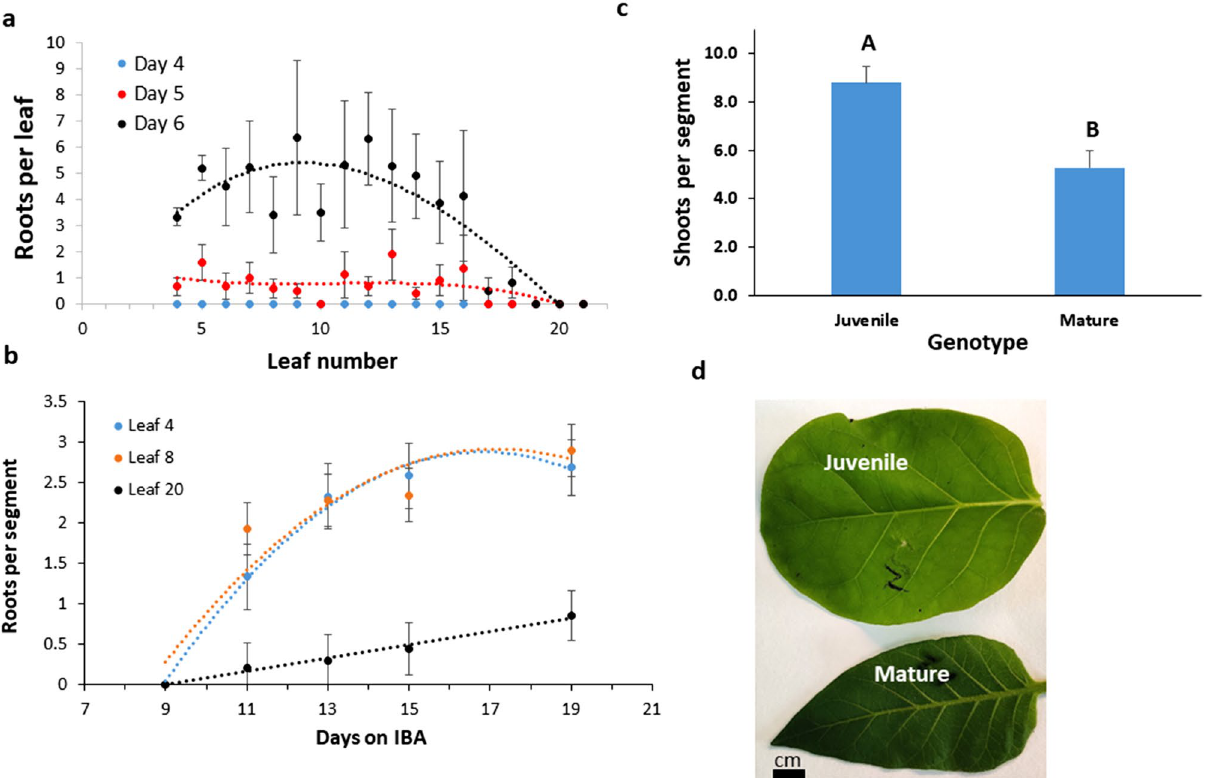
Figure 1. Effect of leaf age on regeneration. Tobacco leaves were detached at the plant’s petiole-stem junction and numbered starting from the first true leaf and were placed in agar supplemented with IBA. ( a ) The number of roots ± SE regenerated from leaf petioles were counted after 4, 5, and 6 days in IBA each day. The experiment was done in 2 replicates with 5–7 leaves each leaf number. Percent regeneration can be seen in figure S2. ( b ) The number of roots ± SE regenerated from leaf blades of juvenile (leaf 4 or 8) or mature (leaf 20) leaves. The experiment was done in 3 replicates and each 10–15 leaf segment. Percent regeneration can be seen in Fig. S3. ( c ) The number of shoots ± SE regenerated from leaf blades was counted after 30 days on the regeneration medium of mature (leaf 20) or juvenile (leaf 8) segments. The experiment was done in 3 replicates, and each had 20–25 leaf segments. Percent regeneration can be seen in Fig. S3. ( d ) Phenotype difference between mature and juvenile leaves. Statistical analysis was conducted among each color group using the JMP program using Tukey analysis. Different letters depict statistically significant differences between genotypes or treatments (p{f} <